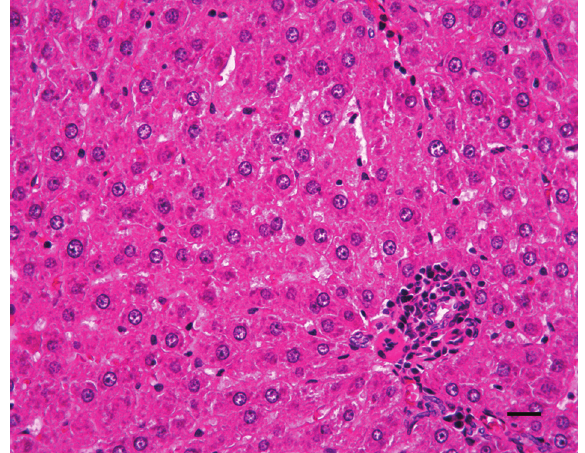
Figure 4. Liver specimen from the cerulein + L-arginine-treated group. The liver section is normal, except for mild sinusoidal dila- tation and congestion. H-E, 40X (bar = 20 µm).